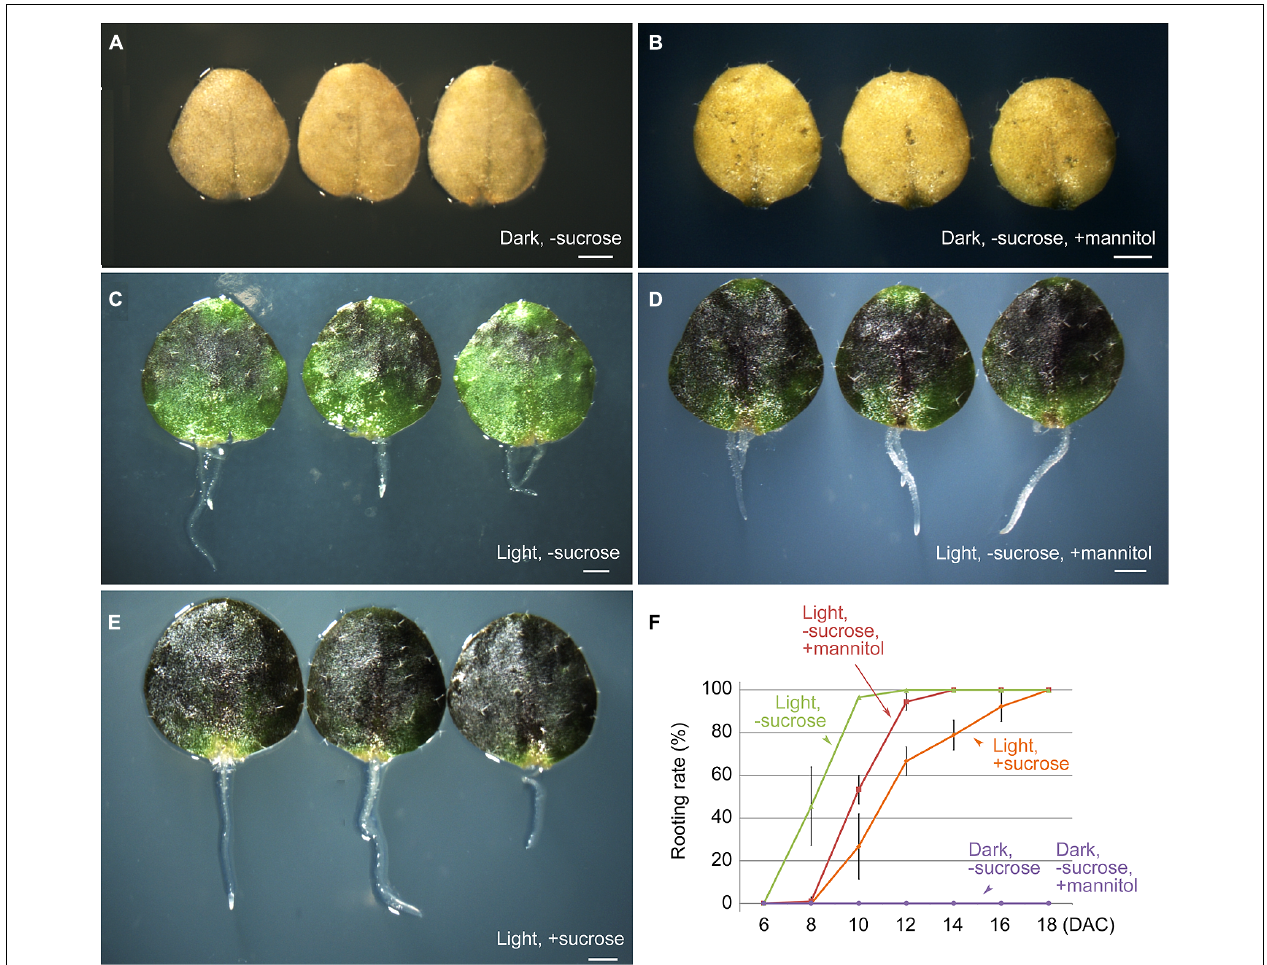
instead of sucrose (D) . (E) Leaf explants at 10 DAC under light conditions on B5 medium with sucrose. (F) Rooting rate analyses of cultured leaf explants for (A–E) . Leaf explants were cut from 12-day-old seedlings. Bars in (F) show SD with three biological repeat. N = 30 for each repeat. Scale bars: 1 mm in (A–E)